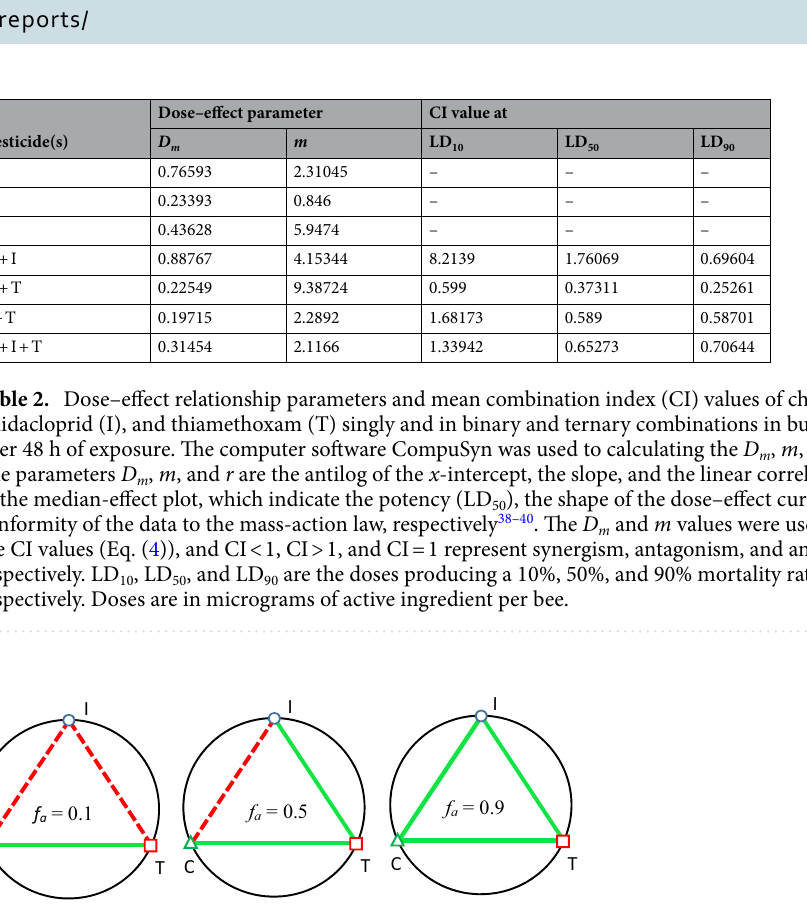
Figure 3. Polygonograms showing the toxicological interactions of imidacloprid (I), chlorpyrifos (C), and thiamethoxam (T) in total combinations when calculated by CompuSyn for the mortality rate of honeybees at three representative effect levels ( f a ), 0.1, 0.5, and 0.9, after an exposure for 48 h. Solid lines represent synergism, and the strength of each synergism is indicated by the thickness of the